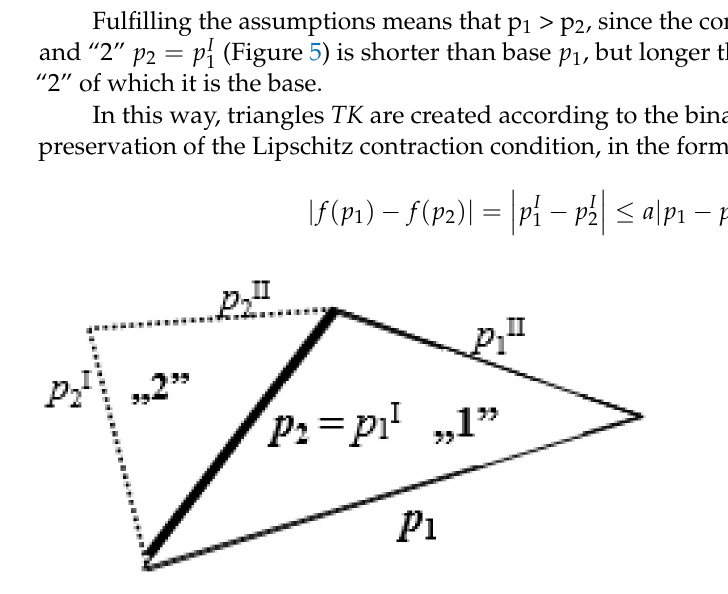
Figure 5. Relation of two neighbouring triangles TK 1 and TK